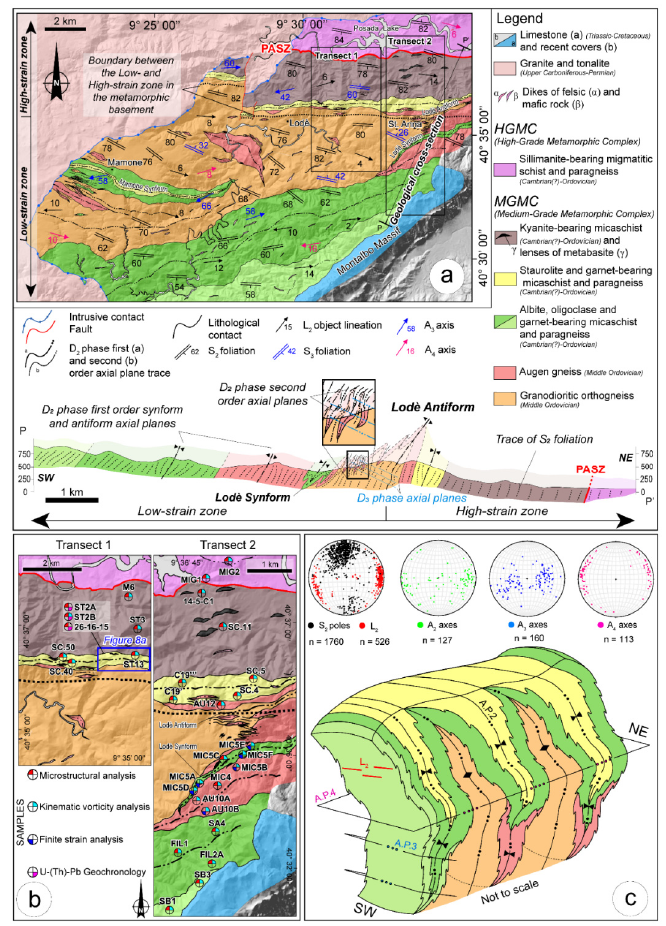
Figure 2. ( a ) Geological sketch map of the study area (Baronie area, see Figure 1). The two sampling transects (1 and 2) and the low- and high-strain zone are indicated. The Posada-Asinara shear zone (PASZ) is also displayed. A geological cross-section, not in the same scale of the map, is present below; ( b ) the details of the two studied areas. Labels of the selected study samples and the corresponding types of analysis are reported; ( c ) 3D simplified block diagram showing the final structural architecture related to the superposition of different deformation phases. Stereoplot (equal angle, lower hemisphere projections) of the main structural elements are given.